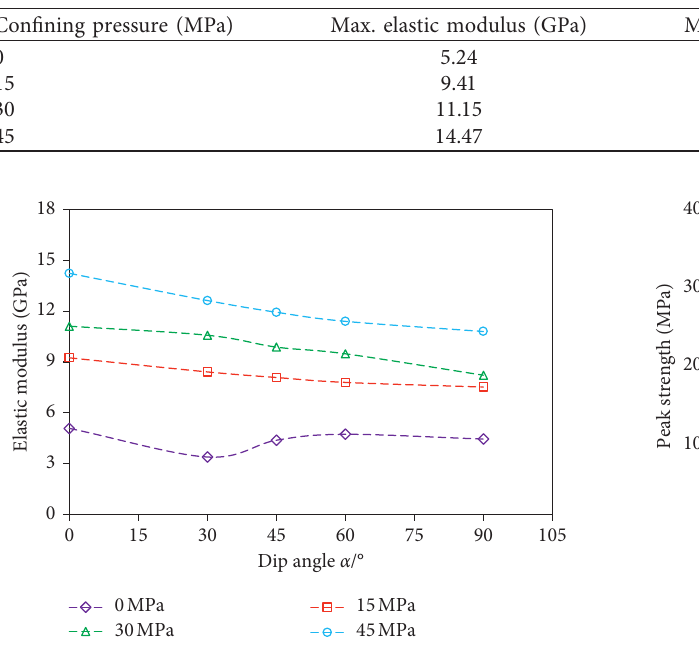
Table 4: Anisotropy degree of elastic modulus.